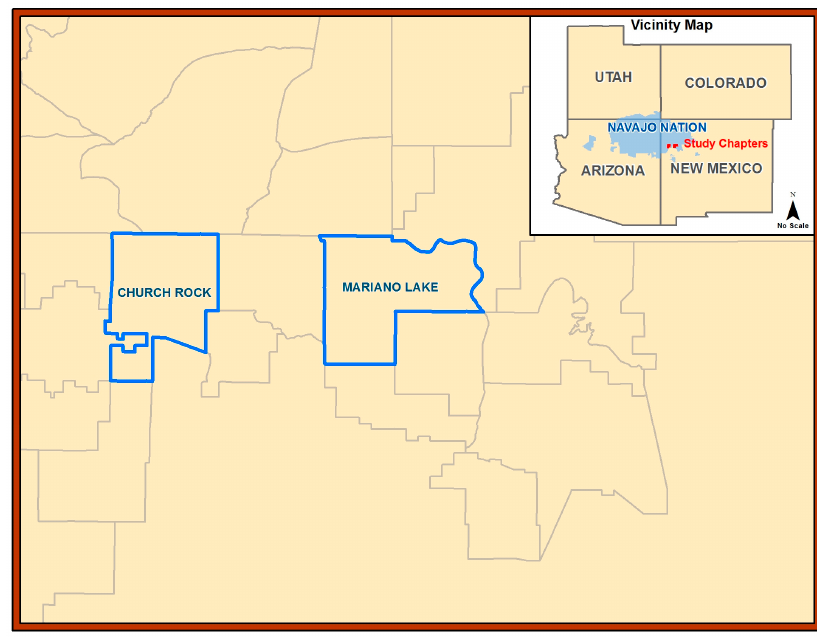
Figure 1. Study area map. Depiction of the Navajo Nation in the Four Corners region of the U.S. Southwest. New Mexico Chapters or communities; Churchrock and Mariano Lake provided sheep tissue and associated samples.